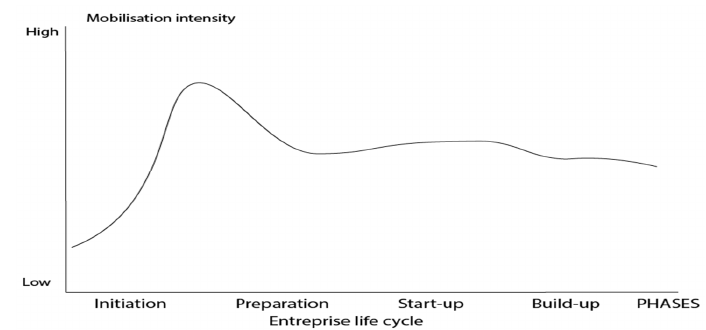
Figure 2. Mobilization of the knowledge and information network.